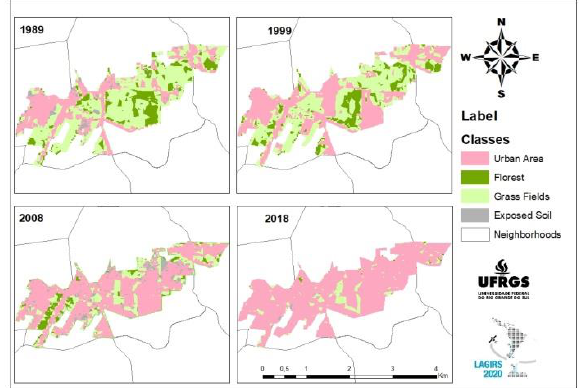
Figure 2. Maps of land use and coverage of 1989, 1999, 2008 and 2018 of the study area.